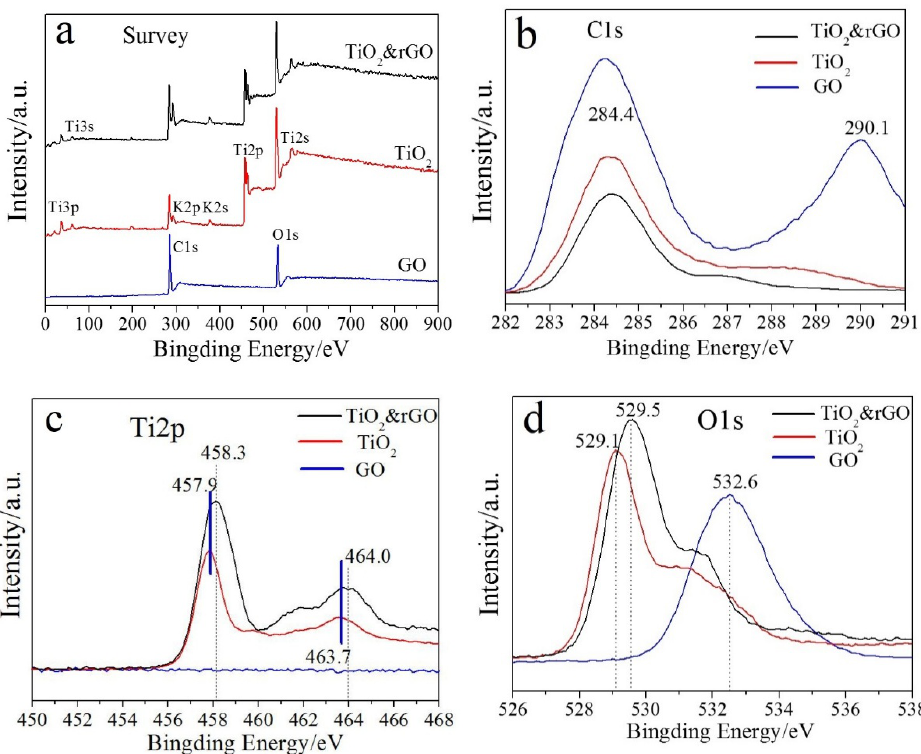
Figure 6. X-ray photoelectron spectroscopy (XPS) of ( a ) XPS survey, ( b ) C1s, ( c ) Ti2p, and ( d ) O1s.